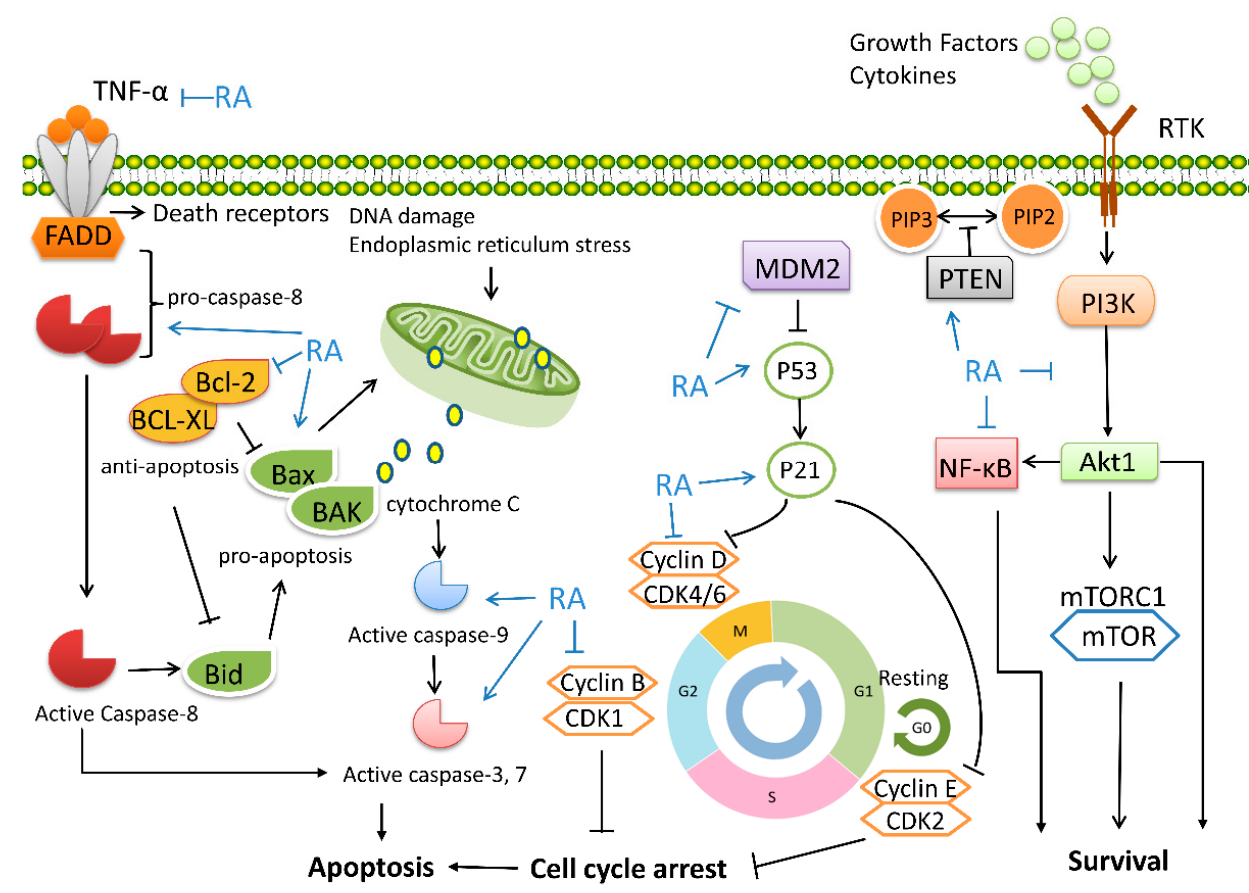
Figure 3. The key mechanisms of anti-tumor effects of RA. Extrinsic apoptosis: RA induces extrinsic apoptosis by upregulating TNF- α and caspase-8. Endogenous apoptosis: RA inhibits BCL-2 and promotes the expression of BAX, caspase-3, -7, and -9 to mediate endogenous apoptosis. P53 pathway and cell cycle: RA inhibits MDM2 expression and promotes p53, p21 expression mediates apoptosis. P21 inhibits Cyclin D and Cyclin E to induce cell cycle arrest, and RA inhibits Cyclin B, Cyclin D, and Cyclin E to mediate cell cycle arrest and promote apoptosis. PI3K/AKT and NF- κ B pathway: RA promotes the expression of tumor suppressor gene PTEN, inhibits PI3K expression, AKT phosphorylation, NF- κ B expression, and p65 phosphorylation, which induces apoptosis through the inhibition of cell survival-related pathways. Table 3. Summary of anti-tumor effects of RA.